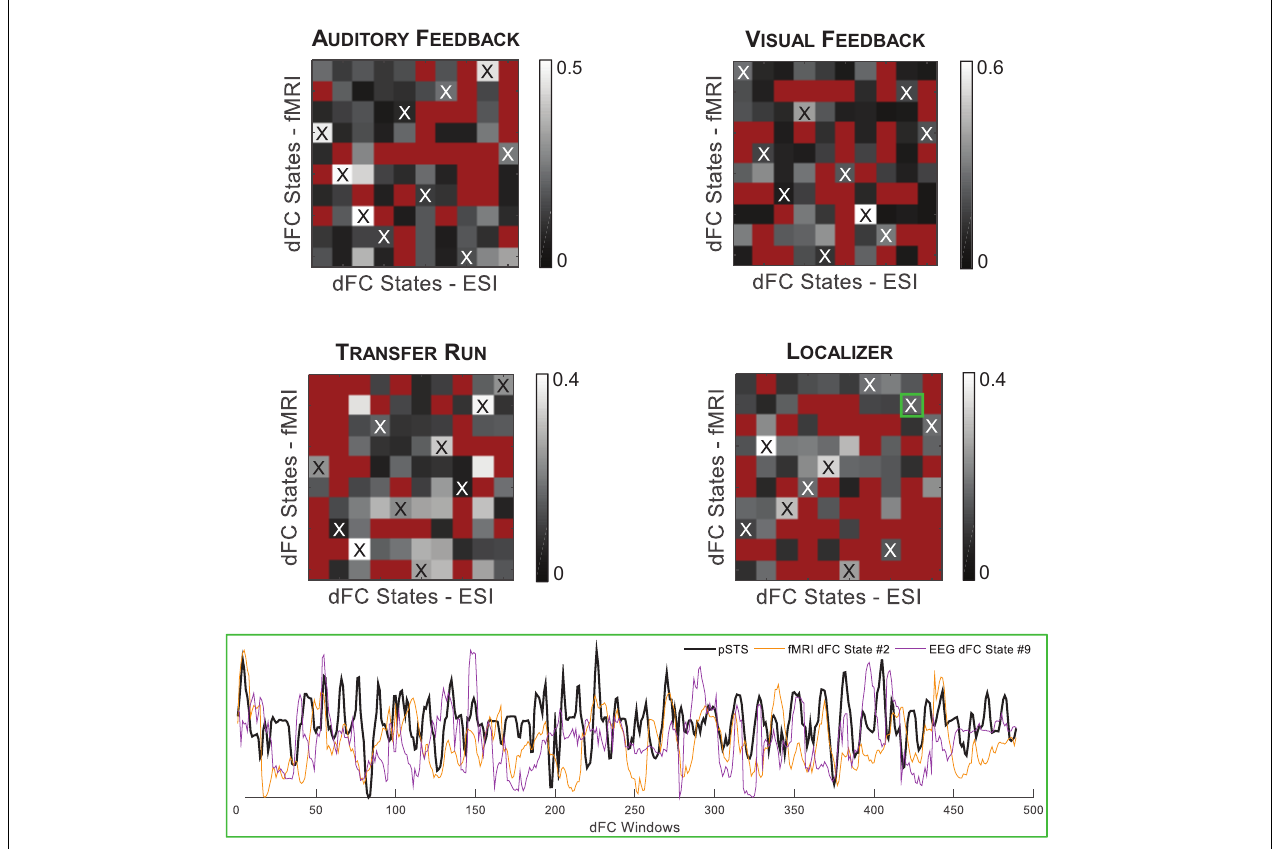
FIGURE 5 | (Top) Spatial correlation between all possible combinations of fMRI ( y -axis) and EEG-ESI ( x -axis) dFC state correlation matrices, for the auditory feedback, visual feedback, transfer, and localizer runs. Red squares denote non-statistically significant ( p > 0.05) spatial correlation values. Matched fMRI and EEG-ESI dFC states are marked by the black or white cross. (Bottom) For the localizer run, the contribution over time of the matched fMRI state #2 and EEG-ESI state #9 (further highlighted by the green square) is shown (orange and purple traces, respectively), superimposed with the contrast of interest used to map the FEPN (black